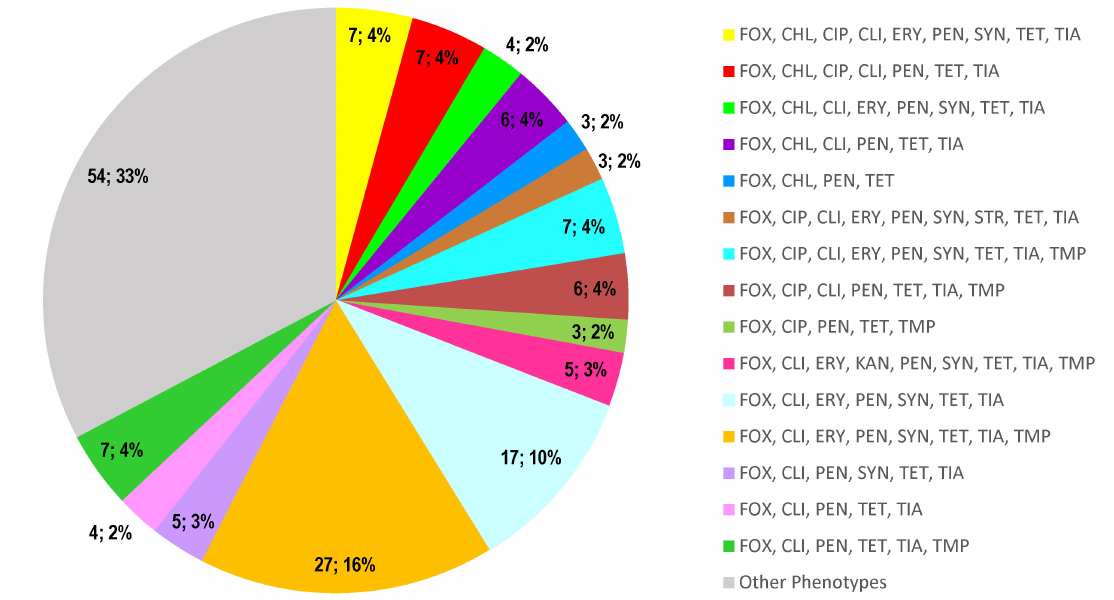
Figure 2. Distribution of the MDR profiles, showing the 15 most common phenotypes of the MDR strains ( n = 165). The number and the percentage of isolates are indicated in the graph. FOX- Cefoxitin, CHL-Chloramphenicol, CIP-Ciprofloxacin, CLI-Clindamycin, ERY-Erythromycin, FUS- Fusidic acid, GEN-Gentamicin, KAN-Kanamycin, LZD-Linezolid, MUP-Mupirocin, PEN-Penicillin, SYN-Quinupristin/dalfopristin, RIF-Rifampicin, STR-Streptomycin, SMX-Sulfamethoxazole, TET-